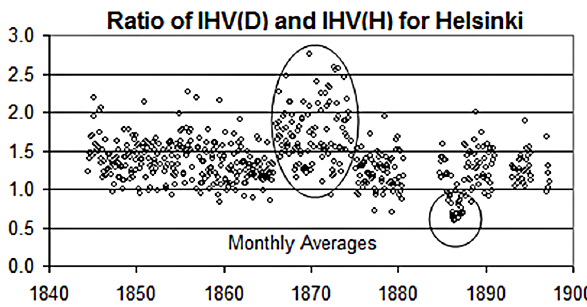
Figure 4. The ratio between monthly values of IHV calculated us- ing the declination, IHV( D ), and of IHV calculated using the hori- zontal force, IHV( H ) for Helsinki. The ovals show the effect of the scale value for H being too low in the interval 1866–1874.5 and of the scale value for D being too low in the interval